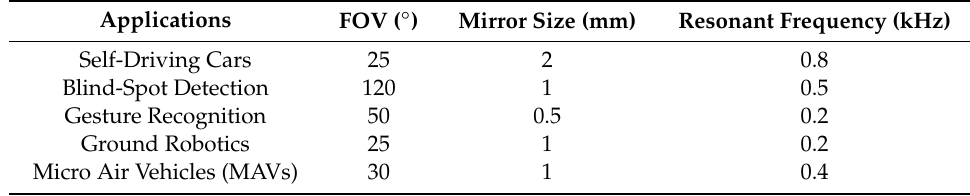
Table 1. The minimal requirements for MEMS mirrors for di ff erent LiDAR applications. Applications FOV ( ◦ ) Mirror Size